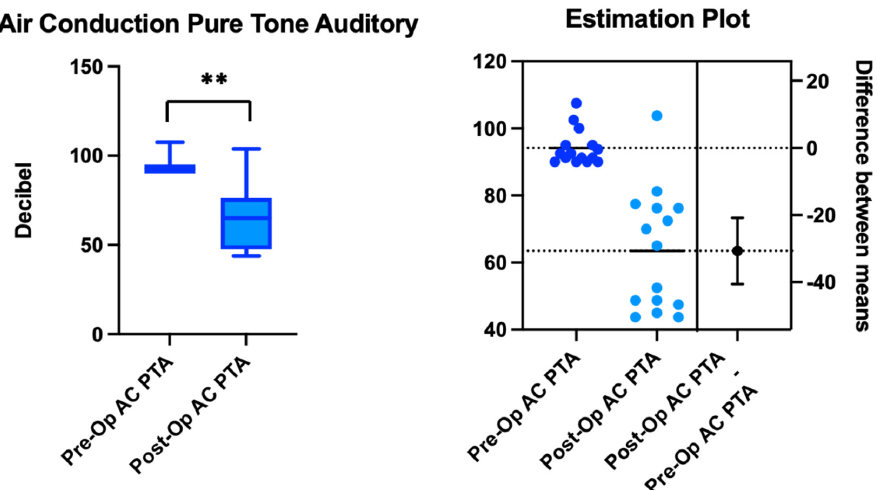
Figure 3. The results of the air conduction (AC) and pure tone average (PTA) tests before (Pre-Op) and after surgery (Post-Op). The estimation plot shows the differences between the means, and the “**” indicates statistical significance of p < 0.0001.